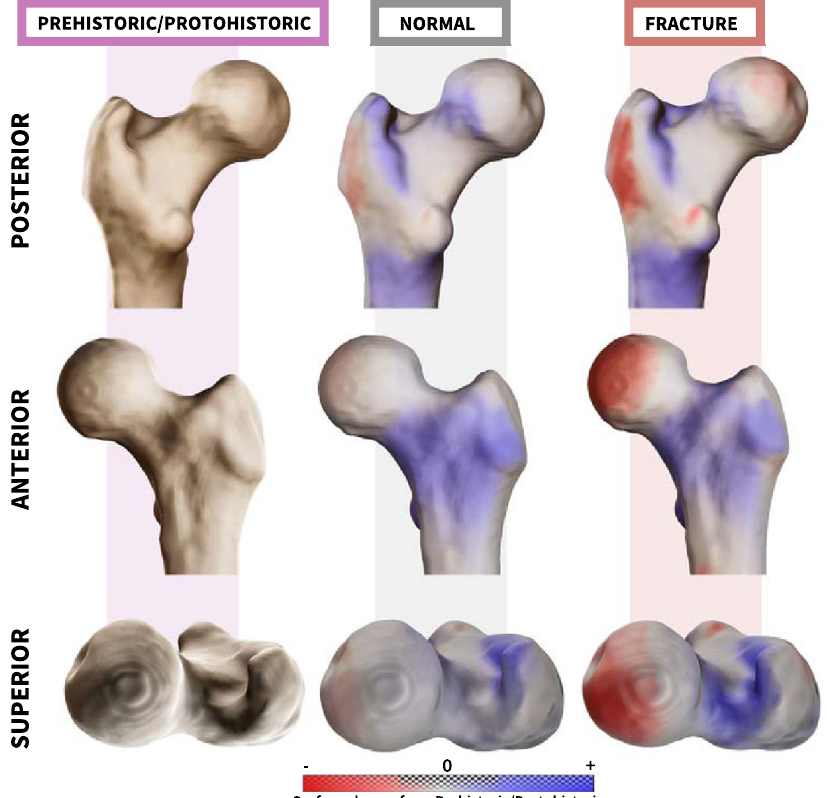
Fig. 4 Superimposition of the proximal femoral mean shape of recent humans (with or without a non-osteoporotic fracture) on the proximal femoral mean shape of the Prehistoric/Protohistoric group. The superimposition of the mean shapes from posterior, anterior, and superior views. The colors indicate the magnitude of shape change (i.e., the distance between surfaces) between the mean shape of the Prehistoric/Protohistoric surface (white) and that of the superimposed one (recent with or without a